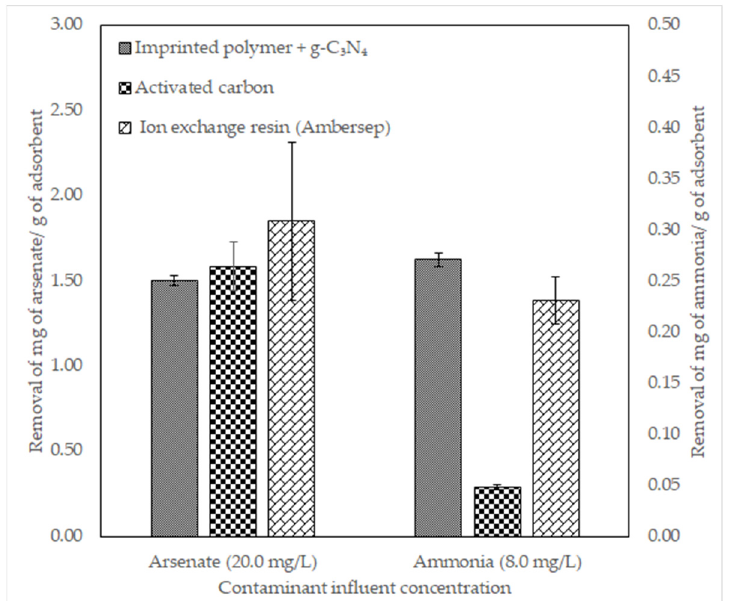
Figure 7. Arsenate and ammonia removal comparison between imprinted polymer with g-C 3 N 4 and commercial adsorbents. The material developed removes arsenate similarly to activated carbon and ion exchange resin Ambersep 21 K. The removal of ammonia is greater than activated carbon and ion exchange resin Ambersep G-26-H.